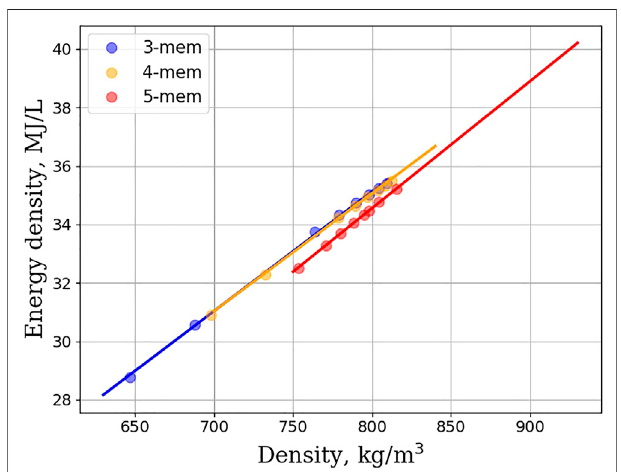
FIGURE6| Energydensity(inMJ/L)asafunctionofdensity(inkg/m 3 )for the homologous series of 3, 4, and 5 membered rings. The linear relationship suggests that the energy density and density are insensitive to the chemical structure of multisubstituted linear cycloalkanes. Data are fi t to a linear